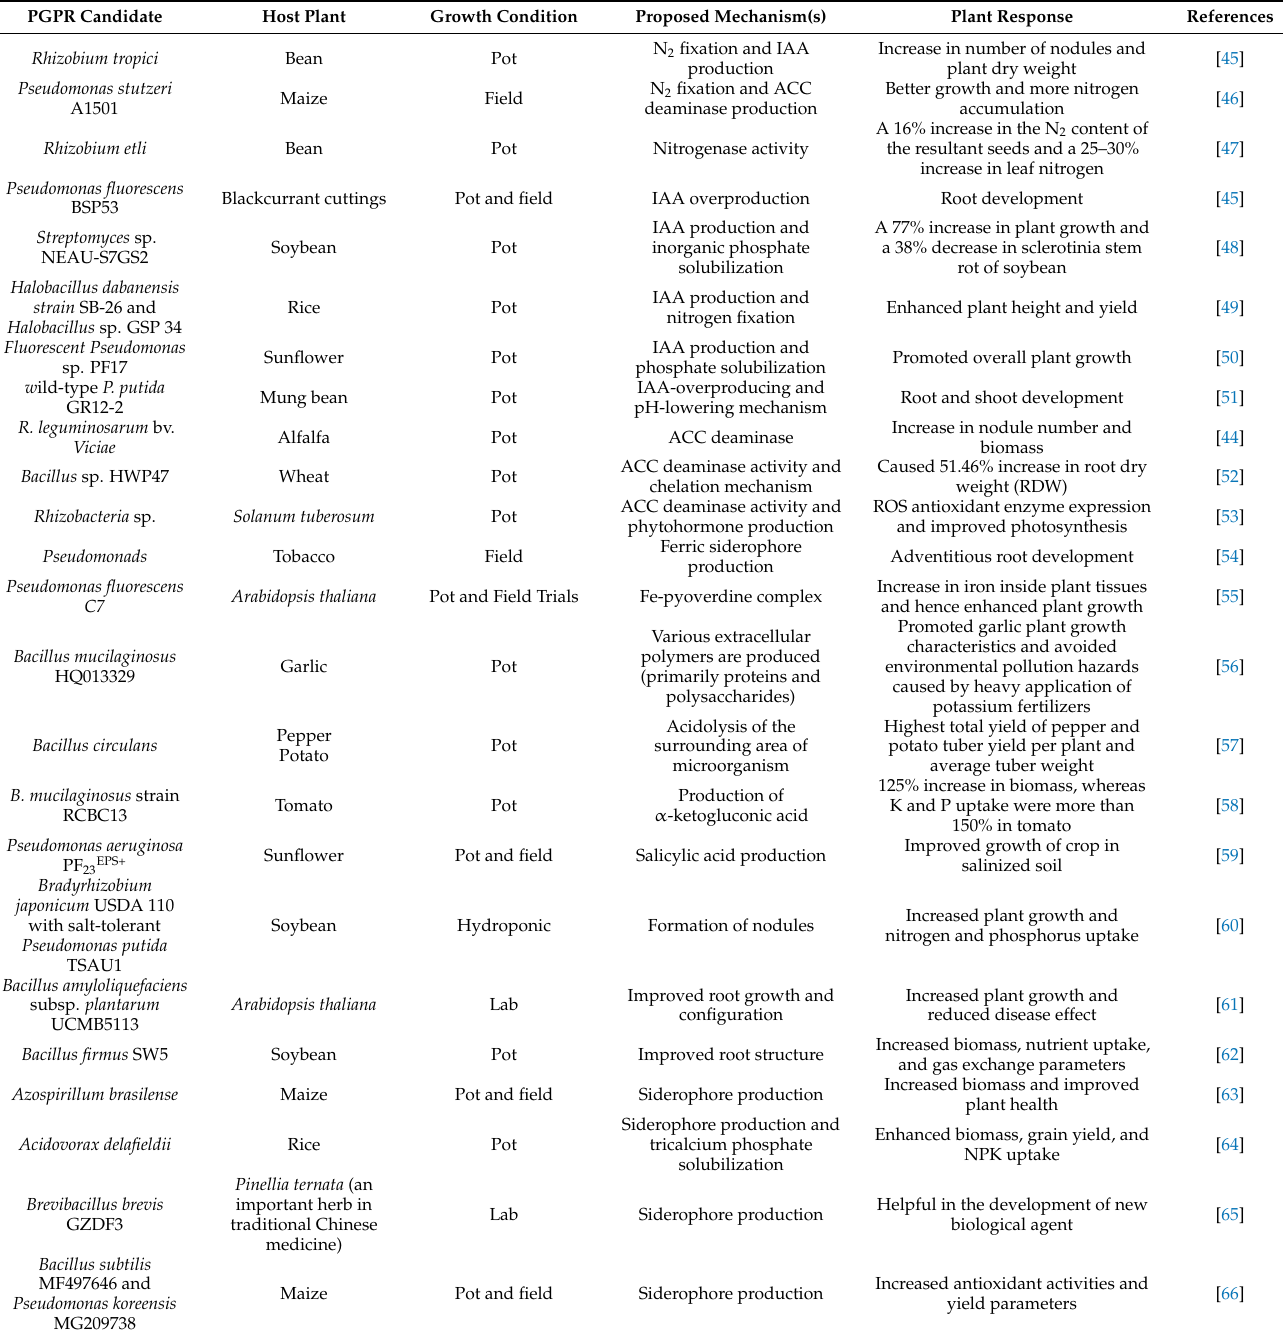
Table 1. Summary of studies on rhizobacterial mechanisms involved in plant growth